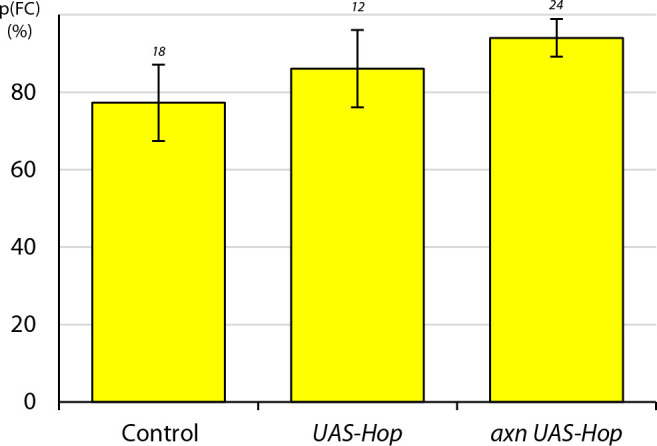
Excess JAK-STAT pathway activity promotes conversion of layer 1 FSCs to FCs even when Wnt pathway activity is increased.Average probability of a layer 1 FSC becoming an FC during a single budding cycle for the indicated MARCM lineage genotypes with the number of informative germaria scored. This experiment was performed at 22°C; the same genotypes were tested at 25°C with results shown in Figure 6A.Figure 6—figure supplement 2—source data 1.Numerical data for graphs in Figure 6—figure supplement 2.